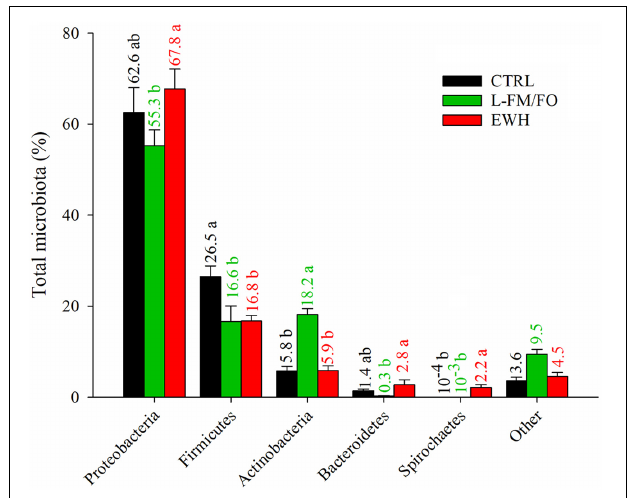
FIGURE 4 | Relative abundance of bacterial phyla in the anterior intestine of fish fed CTRL (black bars), L-FM/FO (green bars), and EWH (red bars) diets. Significant differences (Kruskal–Wallis, Dunn’s post-test, P < 0.05) are indicated by different letters, which correspond to pairwise comparisons within each phylum among dietary groups. The numbers above each bar represent the mean abundance in percentage for each group.